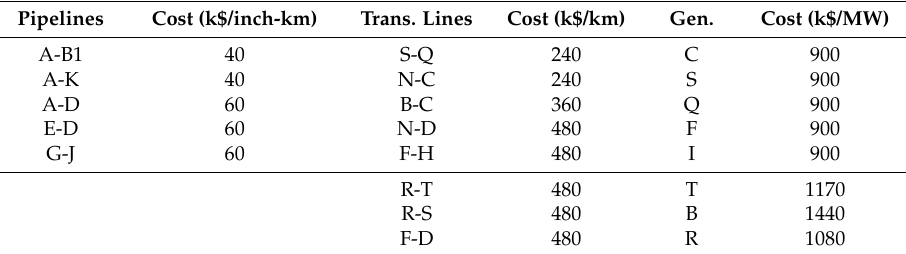
Table 2. Investment cost of expansion candidates.